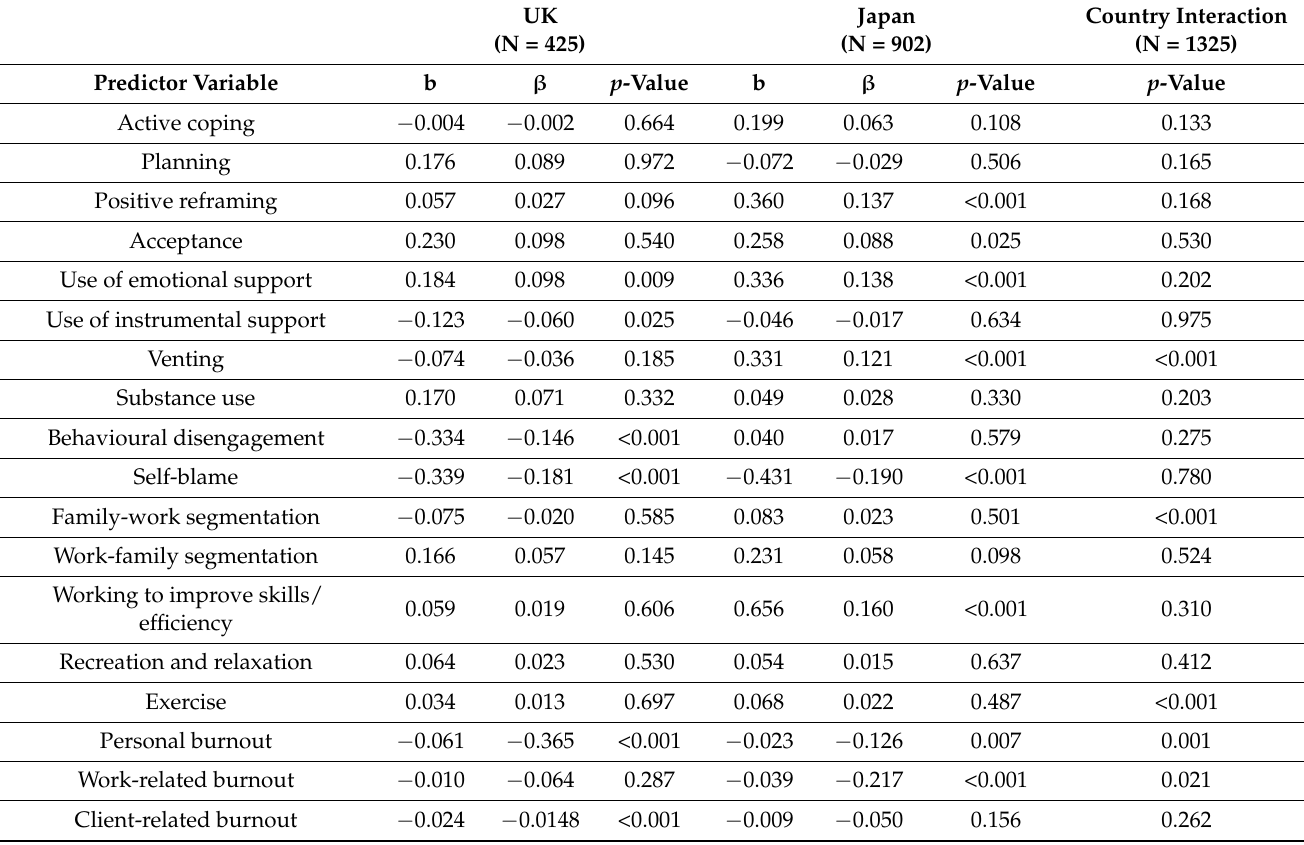
Table 3. Regression analysis examining coping strategies as predictors of